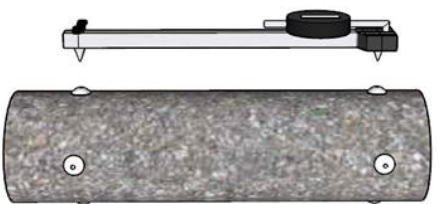
Figure 3. Measuring shrinkage with damage gauge.